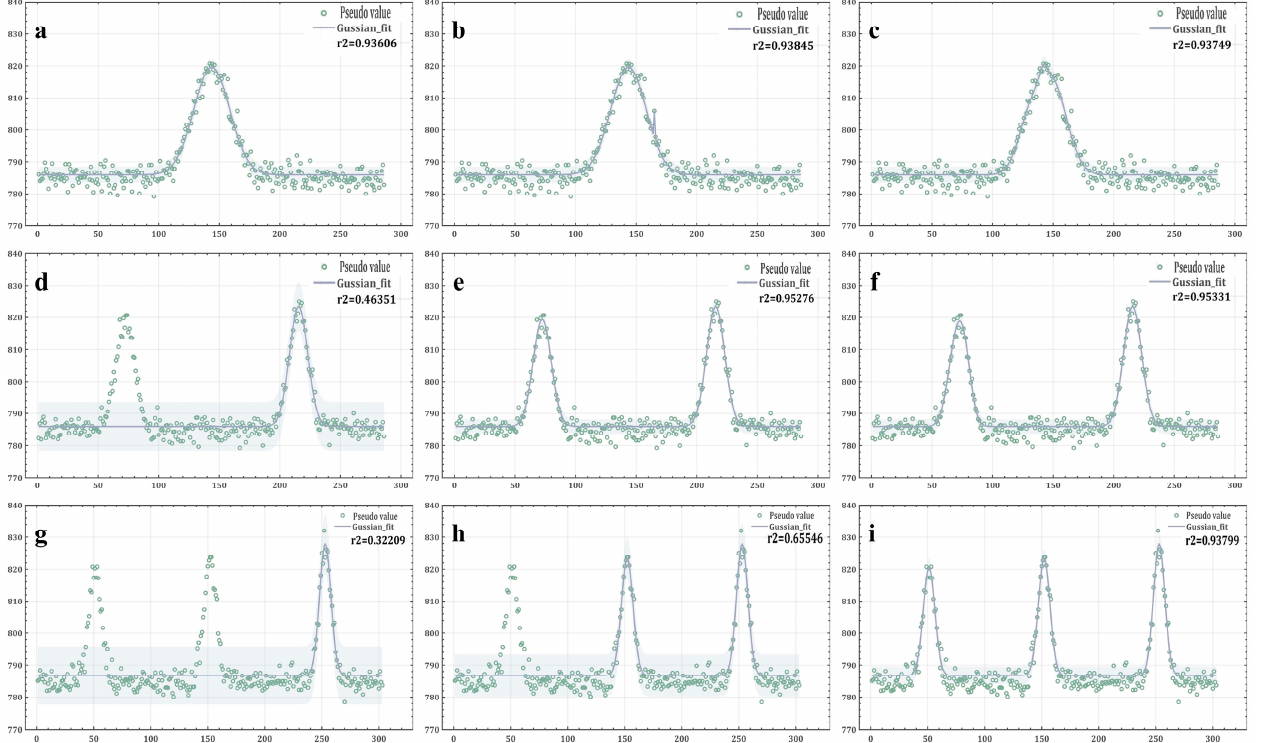
Figure 3. Gaussian mixture model clustering results. After clustering by means of the GMM, we can obtain an optimal estimate of the CO 2 background concentration by averaging the measured values that were fitted to the CO 2 background concentration. Compared to the predetermined value of 785 mg/m 3 for the real CO 2 background concentration in the simulation, the optimal estimate of the CO 2